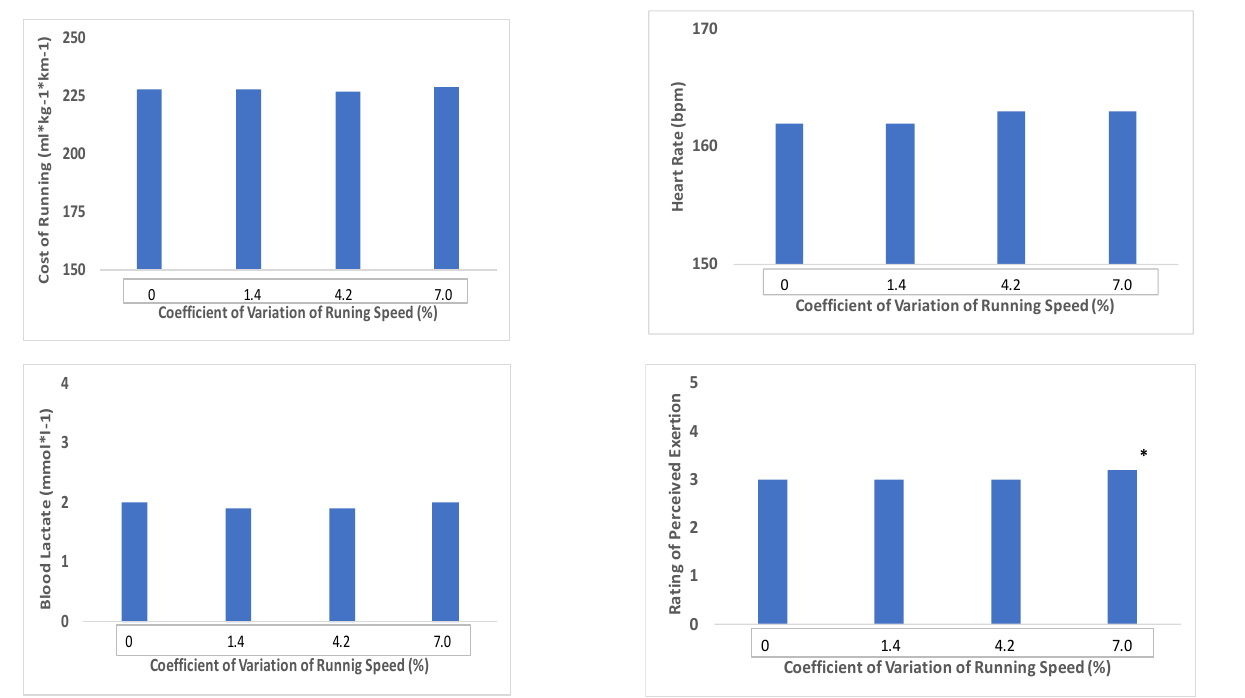
Figure 1. Cost of running expressed as mL · kg − 1 · km − 1 (upper left), heart rate (upper right), blood lactate concentration (lower left), and rating of perceived exertion (RPE) (lower right) in relation to the coefficient of variation (CV) of running velocity, * equivalent to ×.